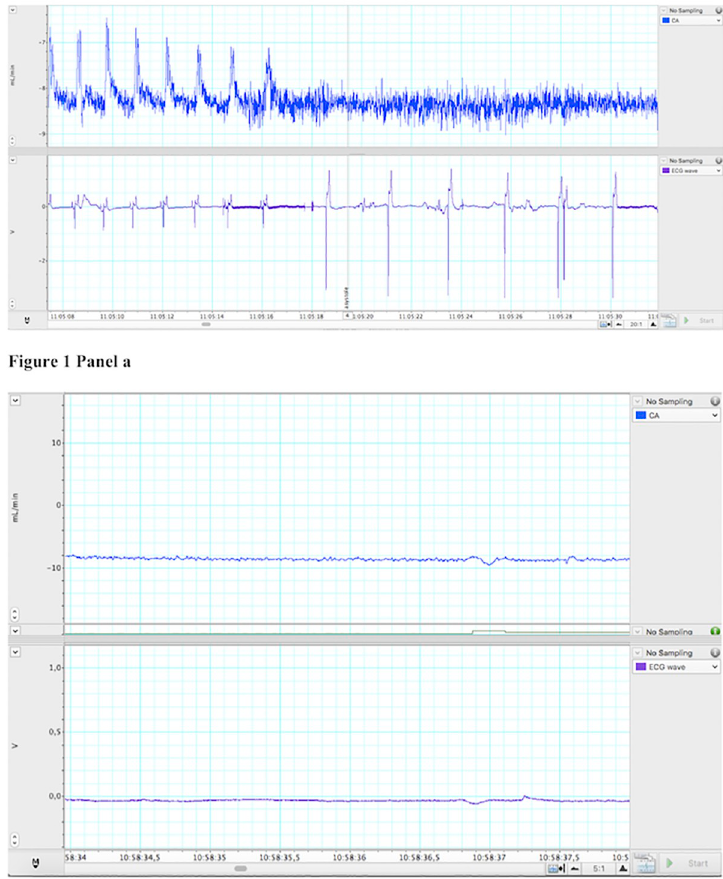
Fig 1. Waveforms of carotid artery (CA) blood flow (CBF) and electrocardiogram (ECG). Panel a: ECG showing bradycardia in the absence of CBF and no audible sound. Panel b: Asystole correctly assessed with absence of CBF, ECG and no audible heart